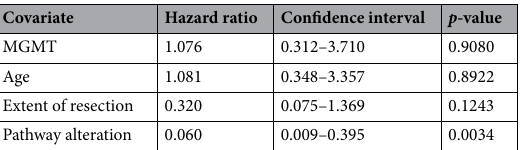
Table 2. Multivariate analysis of factors affecting progression-free survival in patients harboring EGFR or MAPK pathways